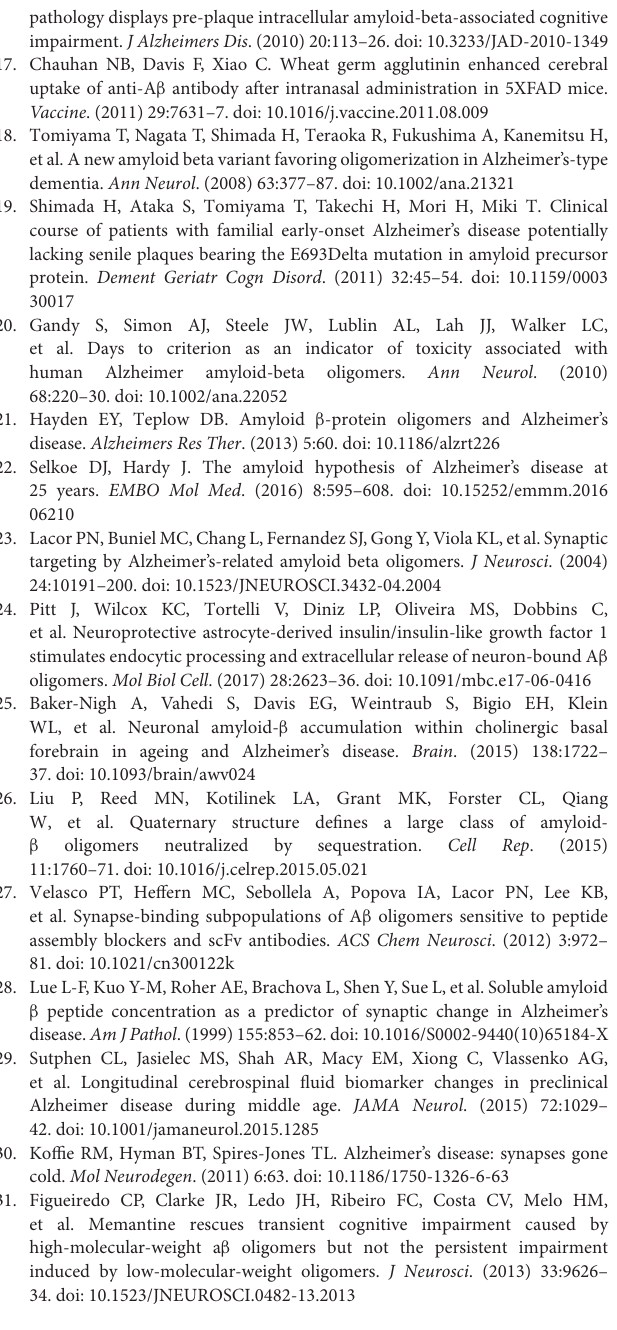
NKA of heart cell membrane ( n = 3). (D) Soluble A β extracted from the cerebral cortex of human AD inhibited activities of NKA in heart membrane of mice ( n = 3). (E) Antibody D70 to oligomers of A β prevent soluble A β extracted from the cerebral cortex of human AD inhibiting activities of NKA in heart cell membrane of mice ( n = 3). Each value is expressed as mean ± SEM. ∗ p < 0.05, ∗∗ p < 0.01, ∗∗∗ p < 0.001, # p < 0.05, ## p < 0.01. Supplementary Figure 2 | Antibody D70 to A β Os prevented A β Os inhibiting NKA activity of kidney cell membrane in vitro . (A) Determination of NKA activity curve of kidney cell membrane of mice by NKA enzyme Kit. The maximum enzyme activity